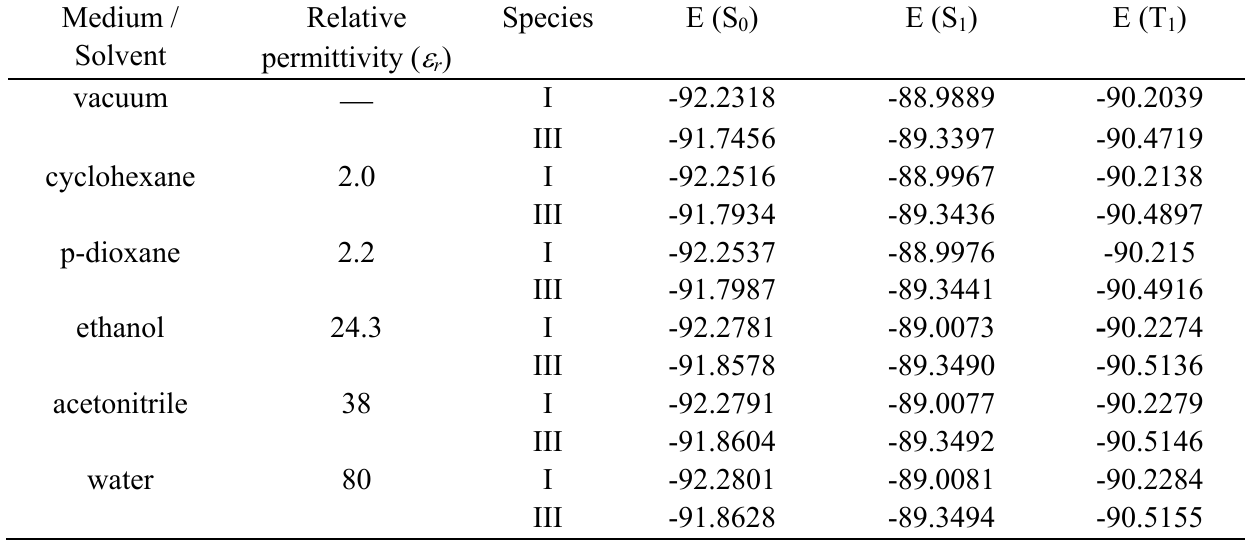
Table 8. Calculated S HPT in isolated and solvated conditions (Onsager’s cavity radius, a = 4.36